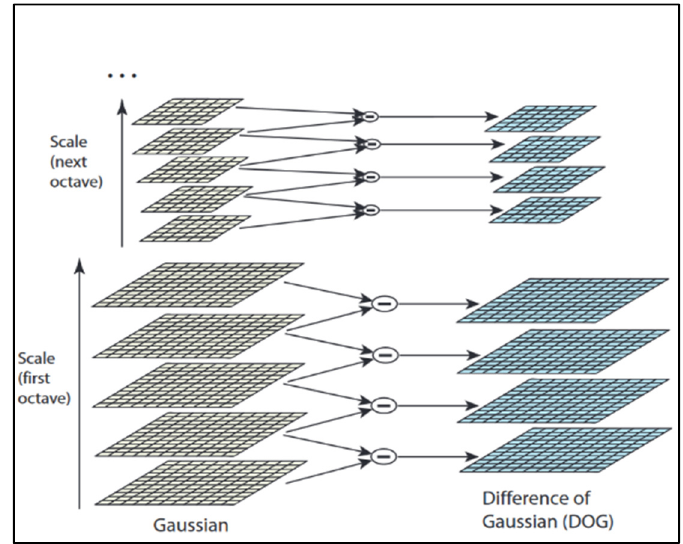
Figure 10. Difference of Gaussian for the detection of rich keypoints. The resulting images after passing through the difference-of-Gaussian function are shown in Figure 11, which shows the pyramid of the difference-of-Gaussian function.